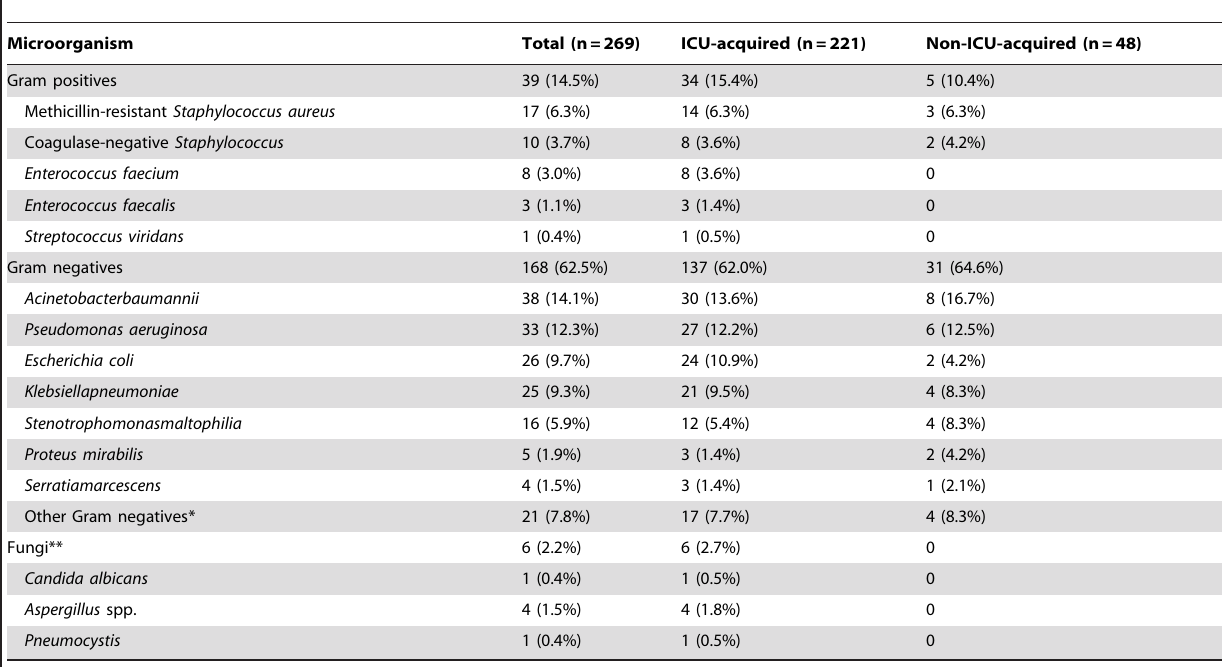
Table 4. Distribution of microorganisms isolated from 148 patients.